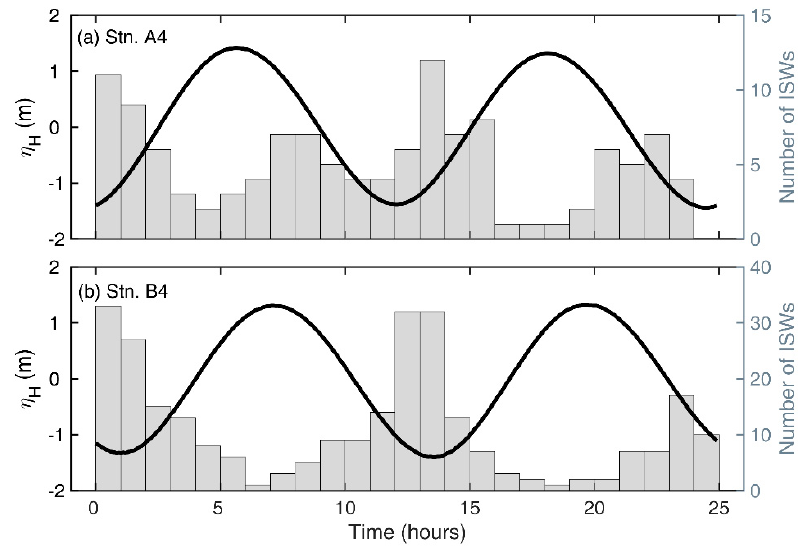
Figure 8. The occurrence of ISWs relative to the tidal phase at ( a ) Stn. A4 and ( b ) Stn. B4. Black curves represent the time series of the tidal elevation simulated using the Ohio State University Tidal Prediction Software (OTPS). The number of ISWs is indicated by vertical bars.